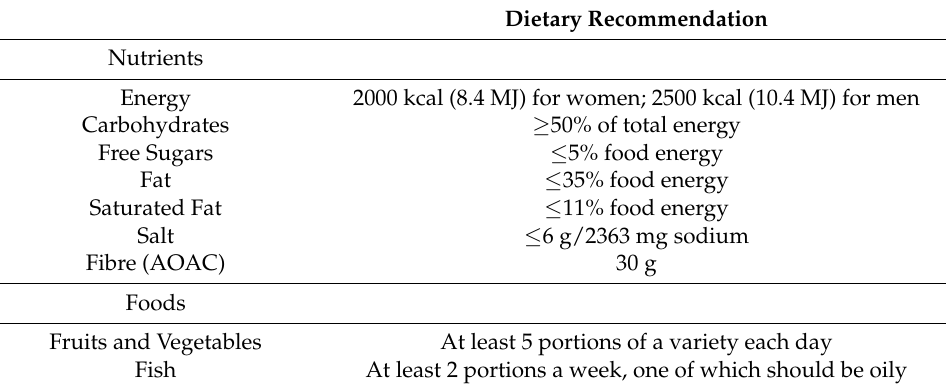
Table 1. UK macronutrient and food recommendations for cardiovascular